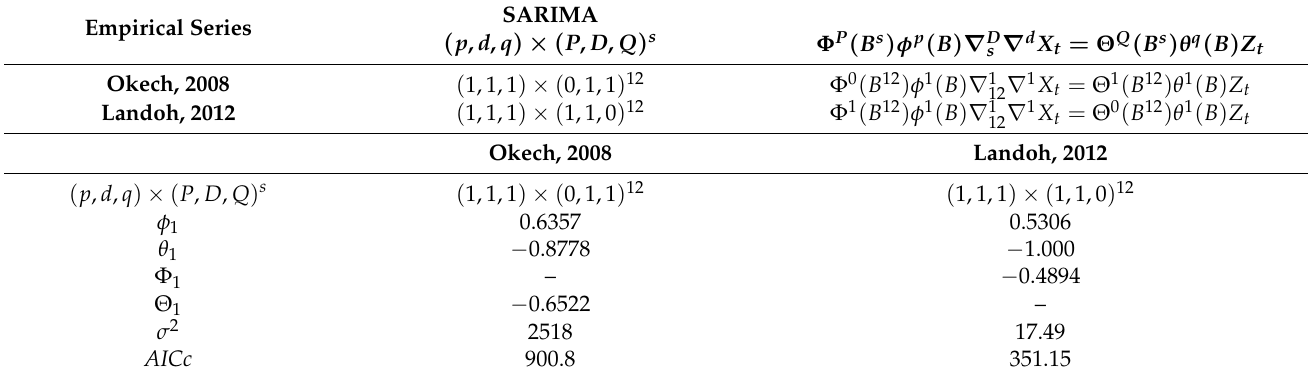
Table A4. ( Top ) SARIMA models of empirical time series from Okech [27] and Landoh [25]. ( Bottom ) Coefficients of SARIMA models of empirical time series from both